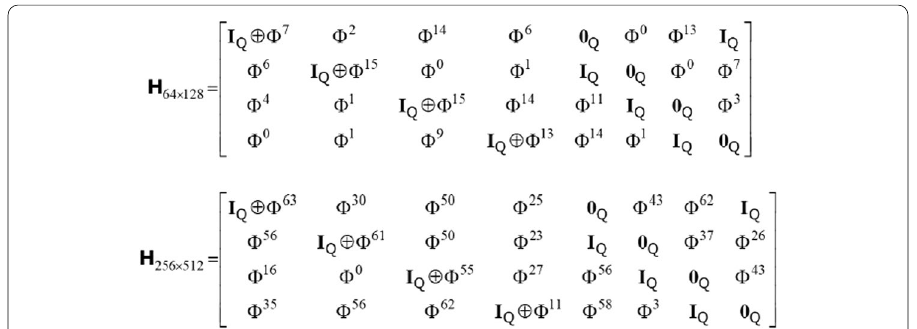
Fig. 6 Parity check matrices of the LDPC